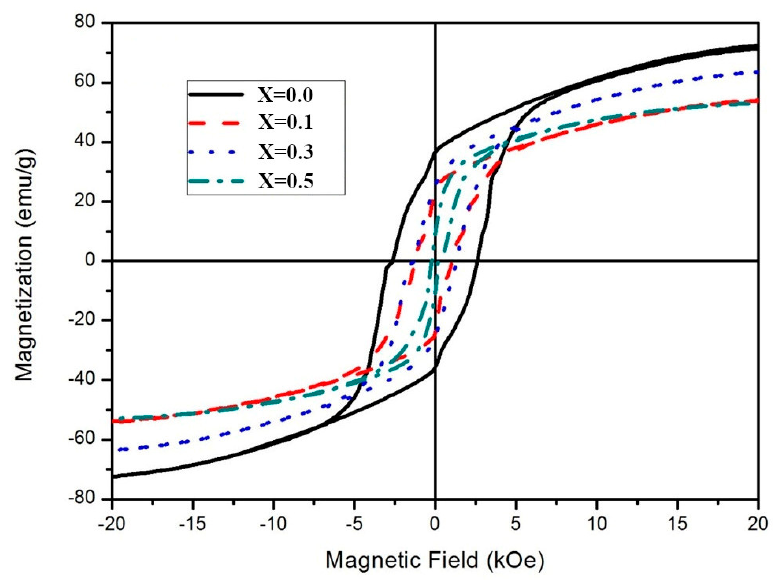
Figure 3. Hysteresis loops of BaFe 12 − x Cu x O 19 (x = 0, 0.1, 0.3, and 0.5) measured by VSM.